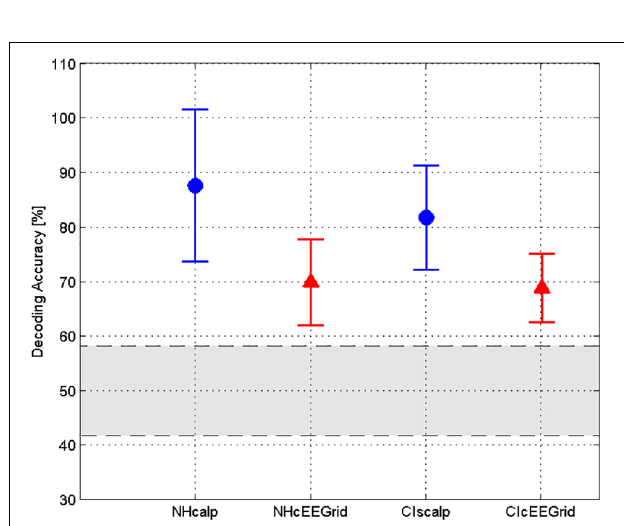
FIGURE 11 | Individually optimized decoding accuracies. Average decoding accuracies for NH listeners and CI users for both, scalp EEG and cEEGrid data. Note, for the CI users the accuracies are obtained using the individual optimal lag and regularization parameter λ . The optimal λ for each CI subject can be found in Table 3 . The gray area indicates the chance